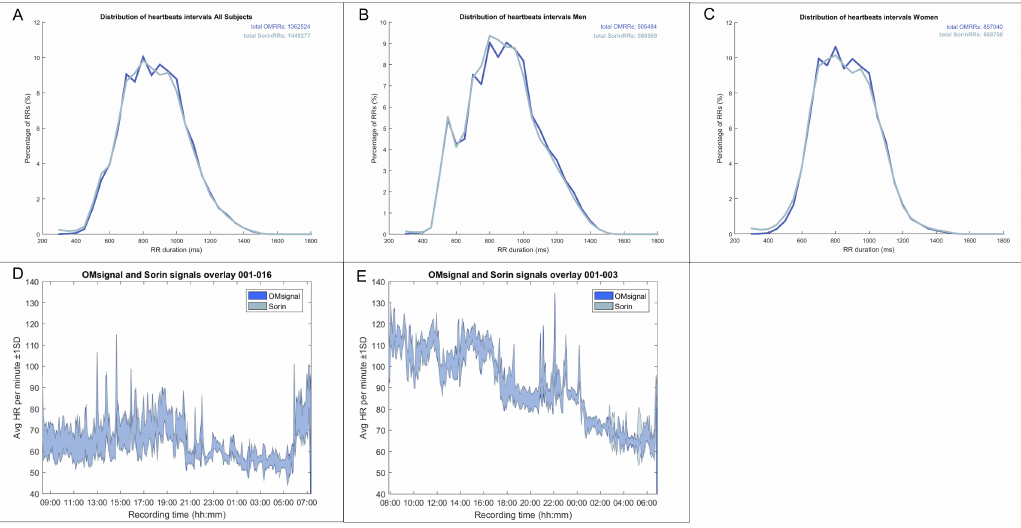
Figure 3. Signal coverage of OMgarments and Holter. Shown is the average signal coverage over 24 h for any given R-R interval ( A – C ) and for any given time point during recording ( D – E ). Note the almost perfect overlay of signal coverage between OMgarments and Holter recordings.